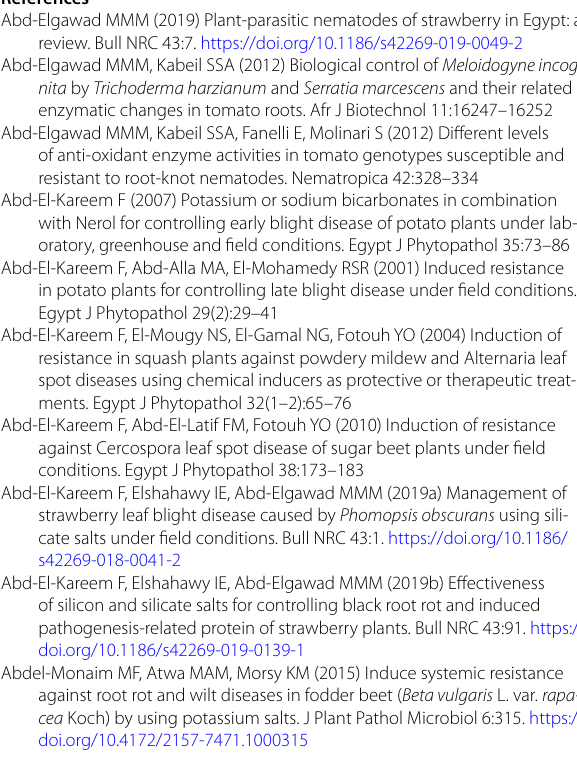
Values with the same letter are not significantly different ( P